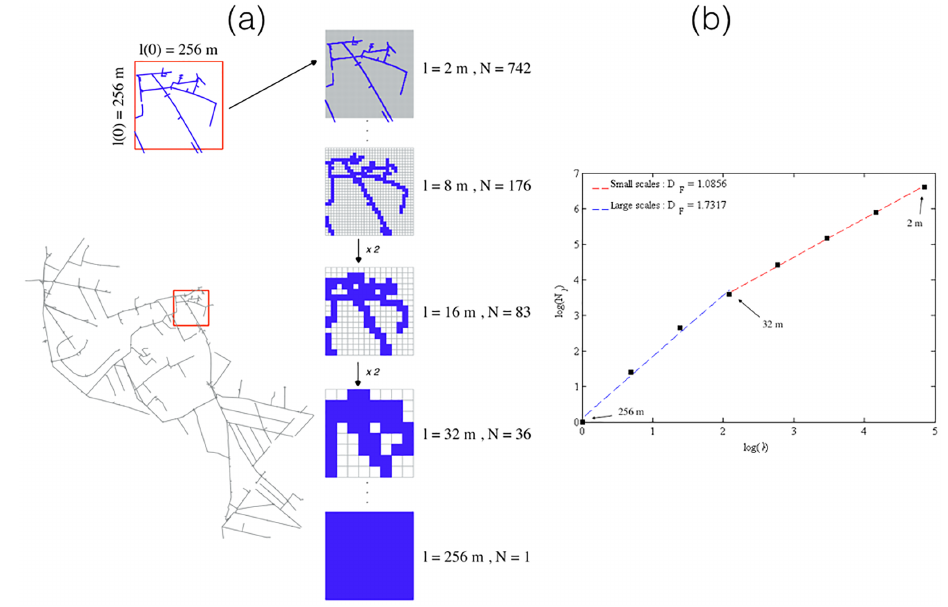
Figure 7. Example of fractal analysis of a portion of the sewer network (256m size). (a) N λ is plotted as function of λ in a log-log plot. (b) A scaling behaviour is retrieved over two separate ranges of scales with a break around 32m.